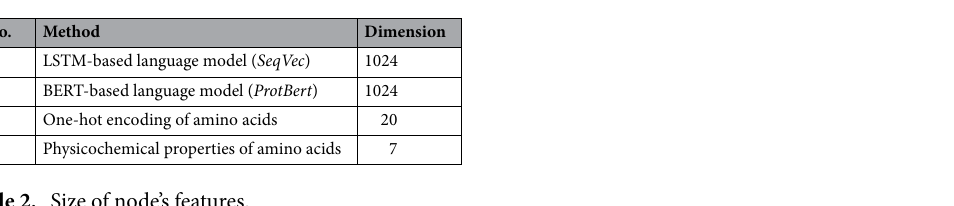
Table 2. Size of node’s